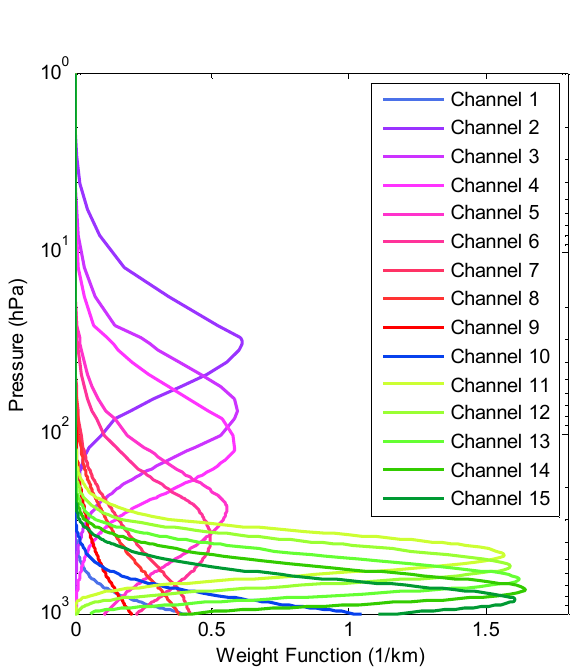
Figure 1. Weight functions for the 15 channels of FY-3C/MWHTS calculated from the U.S. standard atmospheric profile at nadir, assuming a surface emissivity of 0.6.